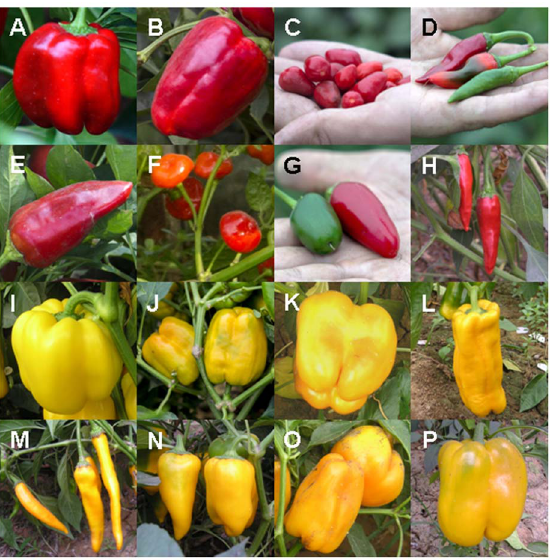
R28, (F) R30, (G) R26, (H) R38; bottom two lines (yellow cultivars): (I) P123-1-1, (J) CK4, (K) CK4-1, (L) CK18, (M) CK7, (N) CK26-1, (O) R12, (P) R19.